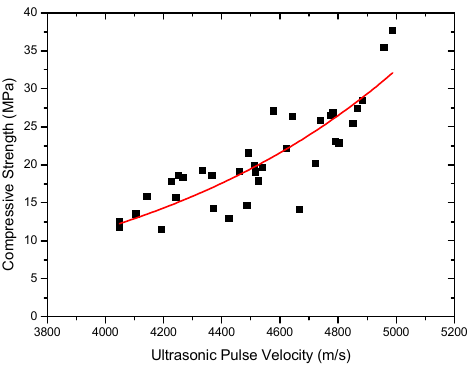
Figure 7. Relationship between UPV and compressive strength.